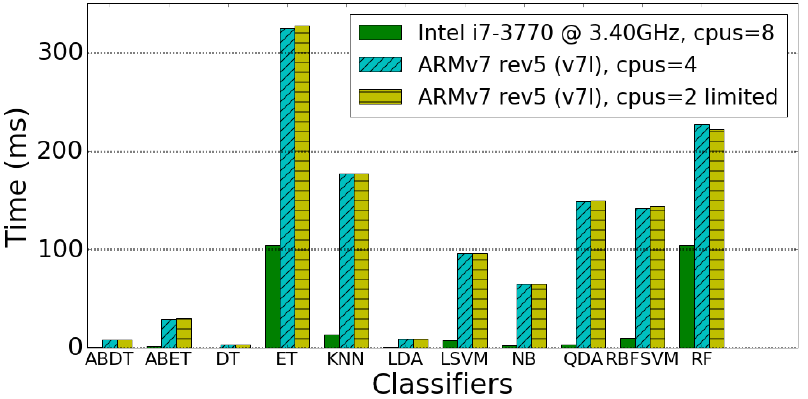
Figure 7. Comparison of average time required for the classification of a sample in several